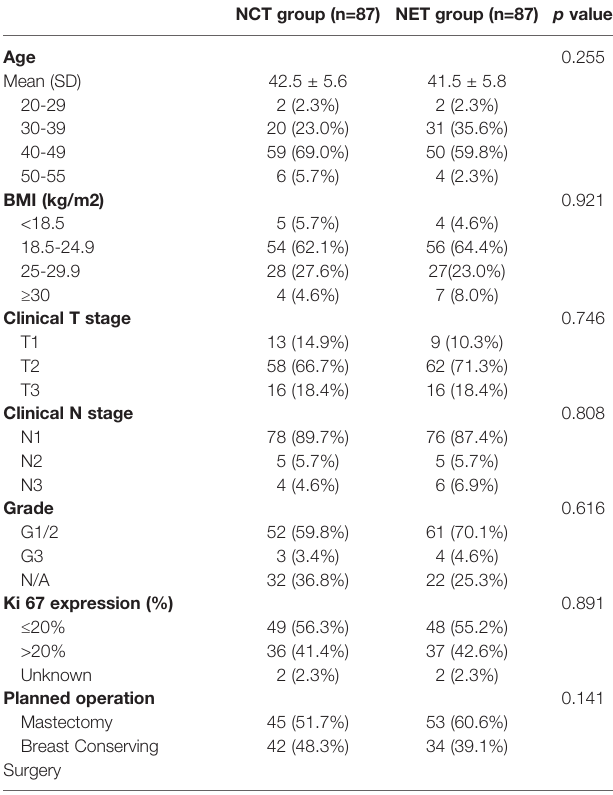
TABLE 1 | Patient demographics and baseline